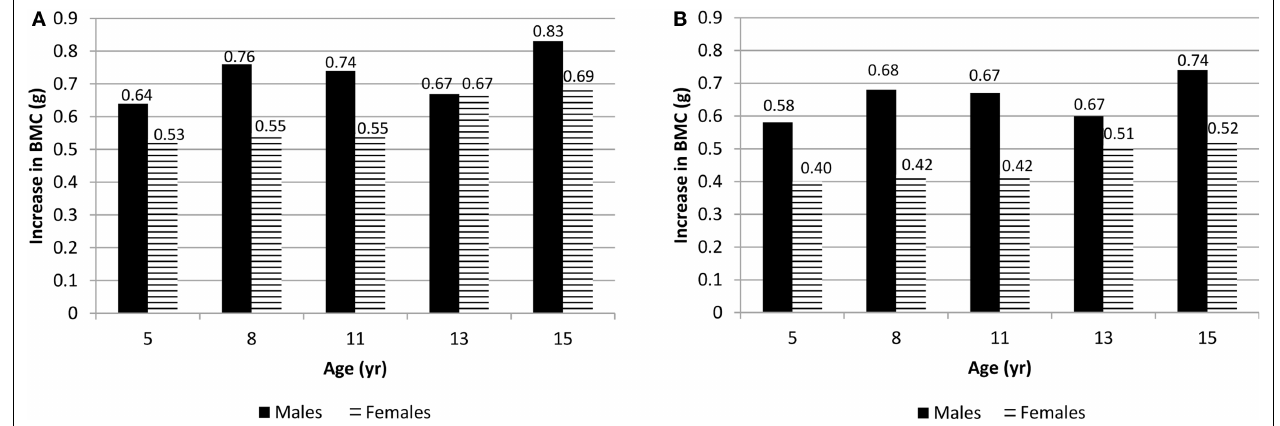
FIGURE 1 | (A) Difference in spine BMC for highVPA (at the 90th percentile) over lowVPA (at the 10th percentile) males and females at all measurement ages. (B) Difference in hip BMC for highVPA (90th percentile) over lowVPA (10th percentile) males and females at all measurement ages. p < 0.05 at all